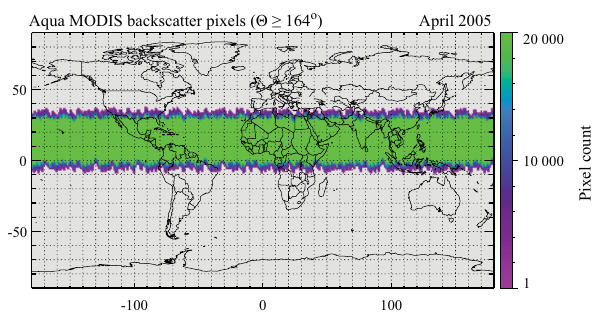
Figure 1. Geographic distribution of the April 2005 Aqua MODIS pixel subset having scattering angles in the backscattering region ( (cid:50) >164 ◦